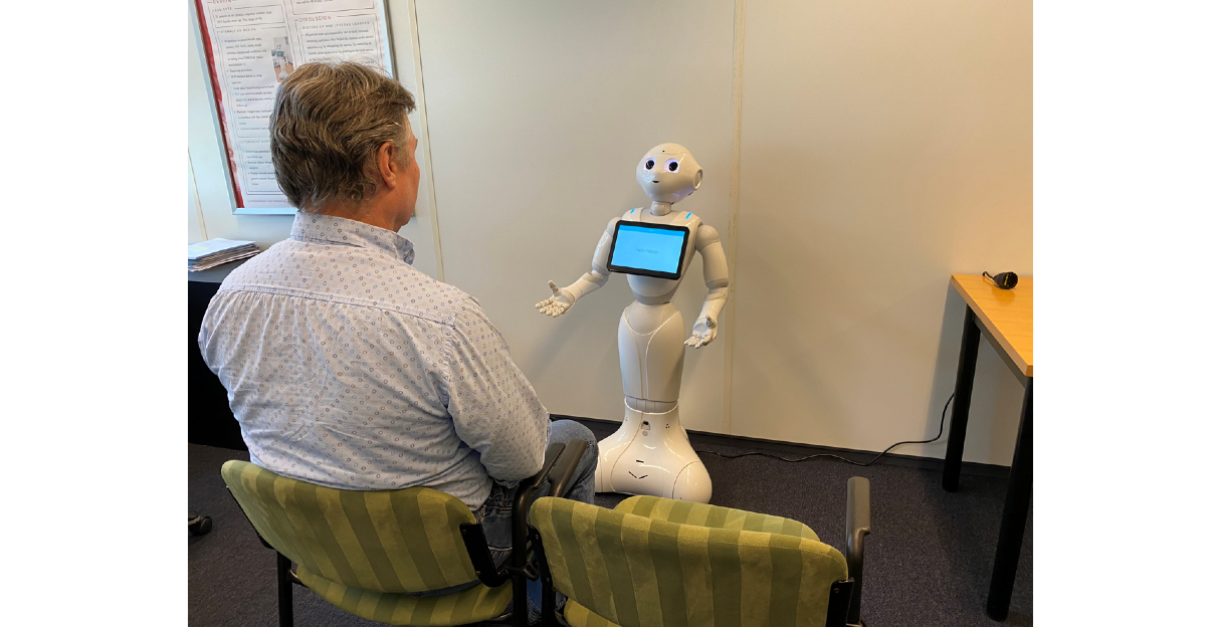
Figure 1. The robot-patient interview setup. The patient sits on the right (not shown) and the informal caregiver sits on the left (person shown was not part of the study population). The distance between the patient and the robot is 90